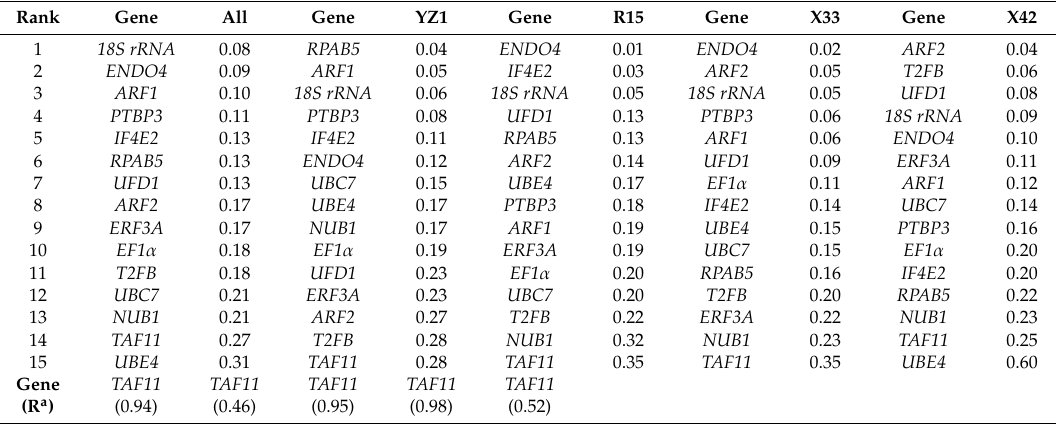
Table 3. Expression stability of the 15 candidate reference genes calculated by NormFinder (Sv) a .